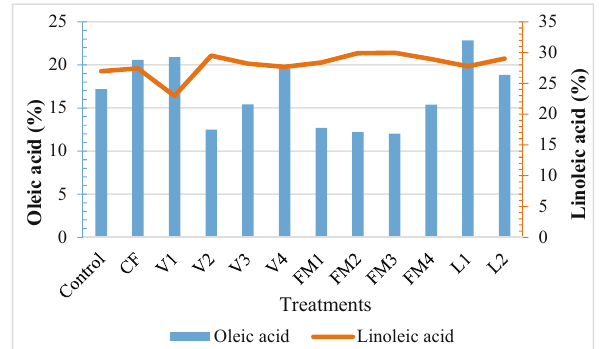
Figure 2: Comparison of the OA and LA ratio in the cowpea